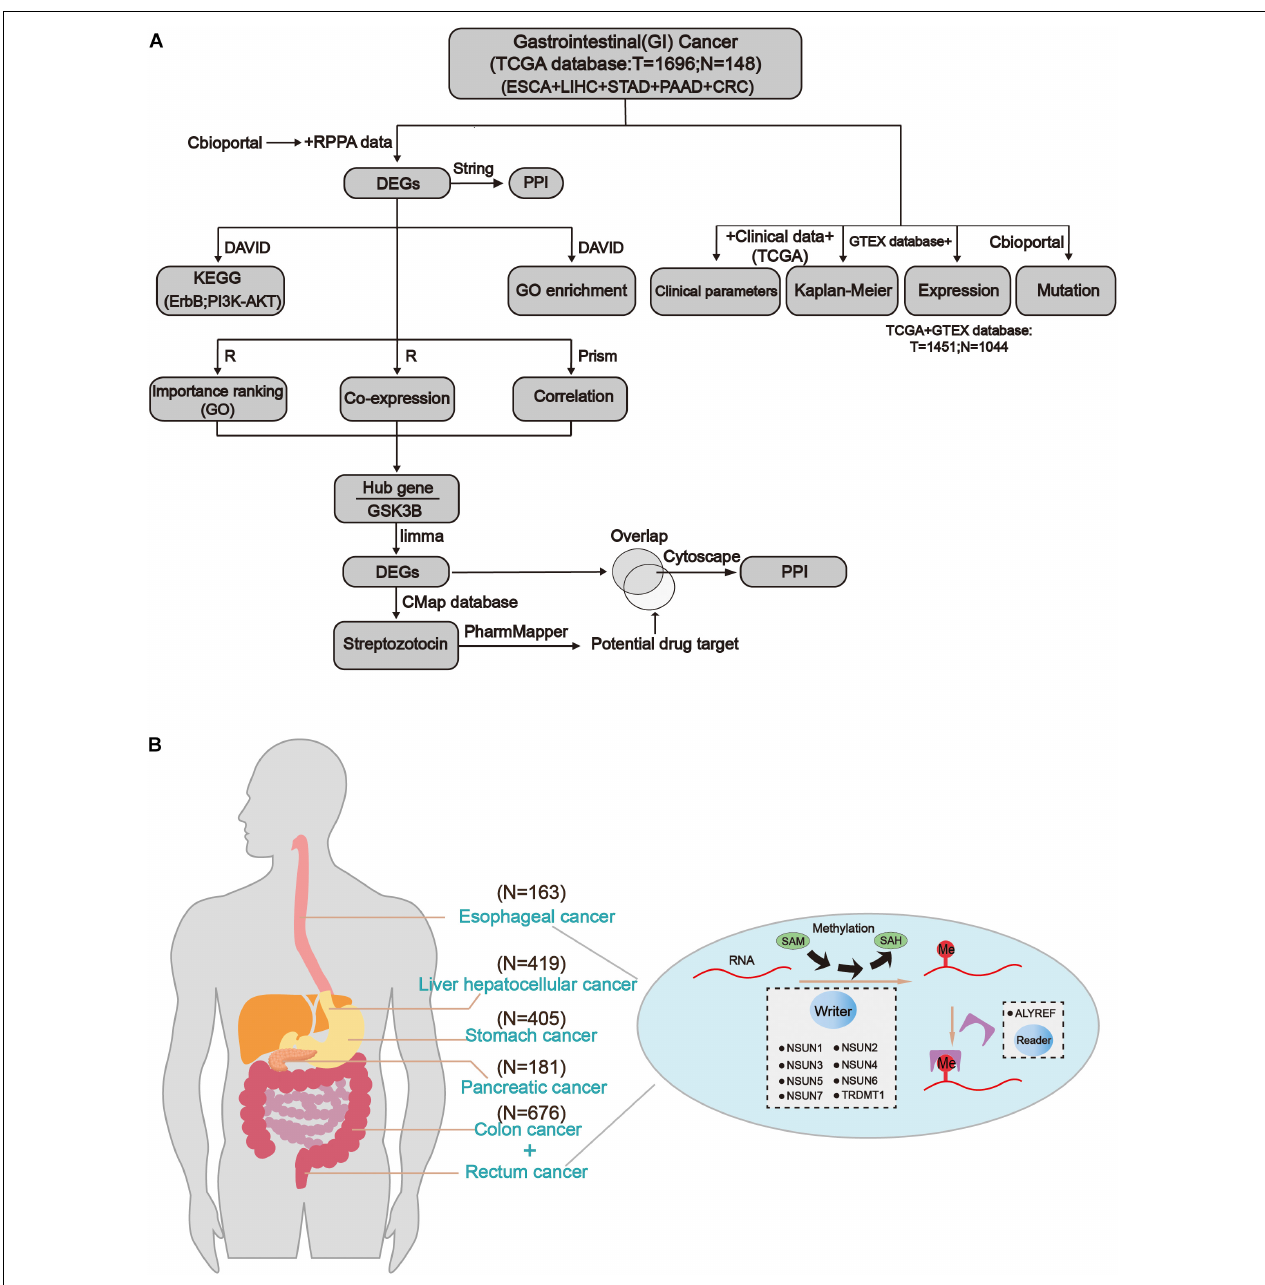
FIGURE 1 | Comprehensive molecular profiling of m 5 C writers and reader in GI cancer. (A) The workflow of the study. (B) The regulation mechanism of m 5 C in GI cancers (esophageal cancer, liver cancer, gastric cancer, colon cancer, and rectal cancer). m 5 C formation is catalyzed by writer and SAM ( S -adenosylmethionine). In addition, reader can recognize methylated mRNA and mediate its export from the nucleus. They work together on m 5 C RNA methylation